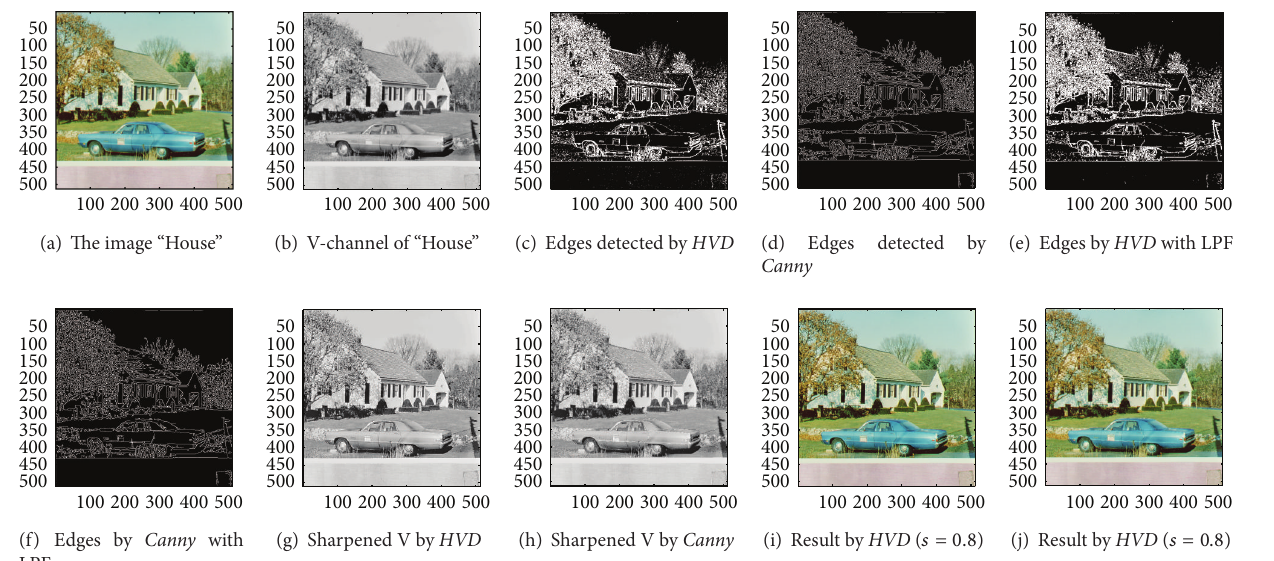
= 13 for HVD . (a) The image “House” (512 × 512 color image). (b) V -channel of “House”. (c) Edges detected by HVD . (d) Edges Figure 4: 𝜃 eth detected by Canny . (e) Edges detected by HVD with LPF. (f) Edges detected by Canny with LPF. (g) Sharpened Value channel by HVD with LPF. (h) Sharpened Value channel by Canny with LPF. (i) Sharpened result by HVD with scaling factor 0.8 . (j) Sharpened result by Canny with scaling factor 0.8